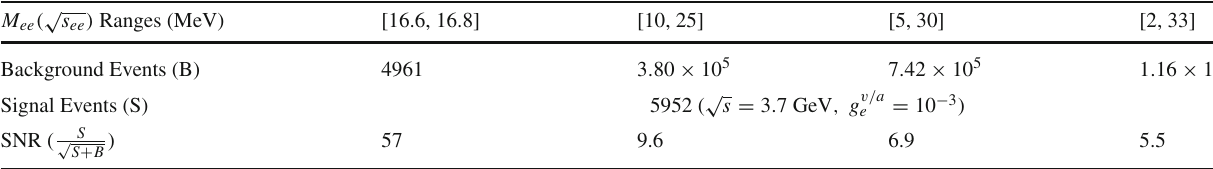
Table 1 The signal-to-noise ratios (SNR) around M ee = 16 . 7 MeV, where we adopt four invariant-mass ranges M ee for the background process. The last three ranges roughly correspond to the energy res-